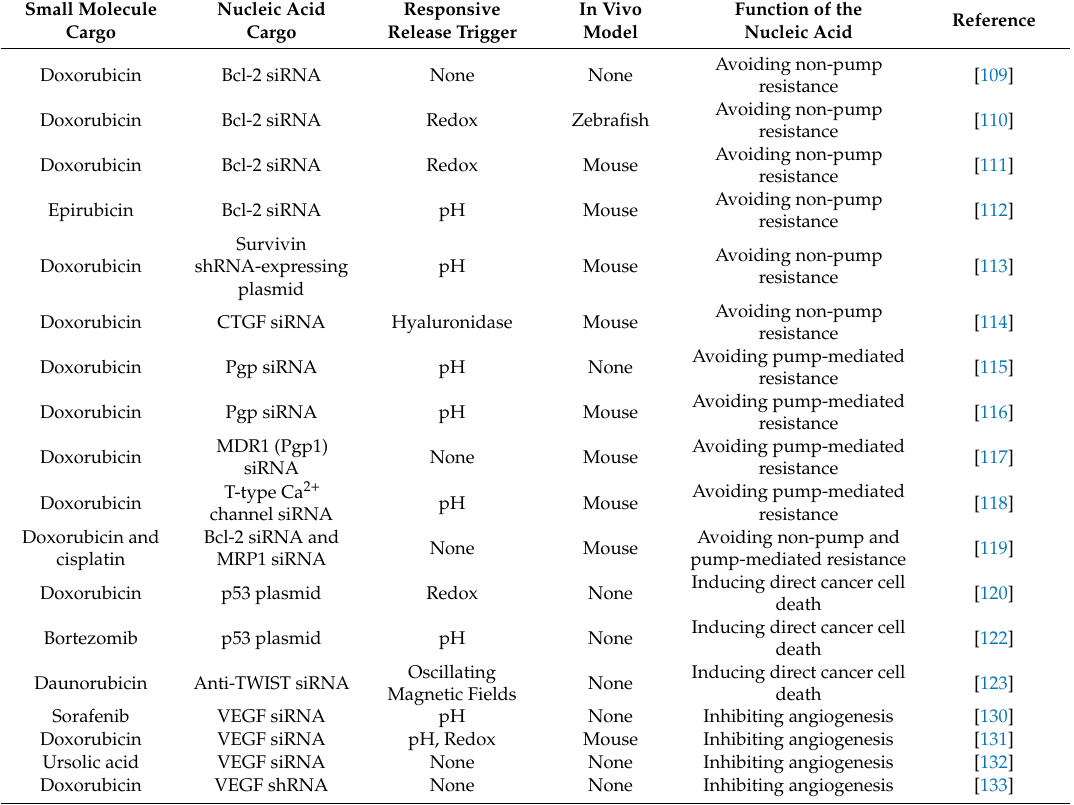
Table 1. Small molecule and nucleic acid cargos co-delivered by MSN-based formulations for cancer